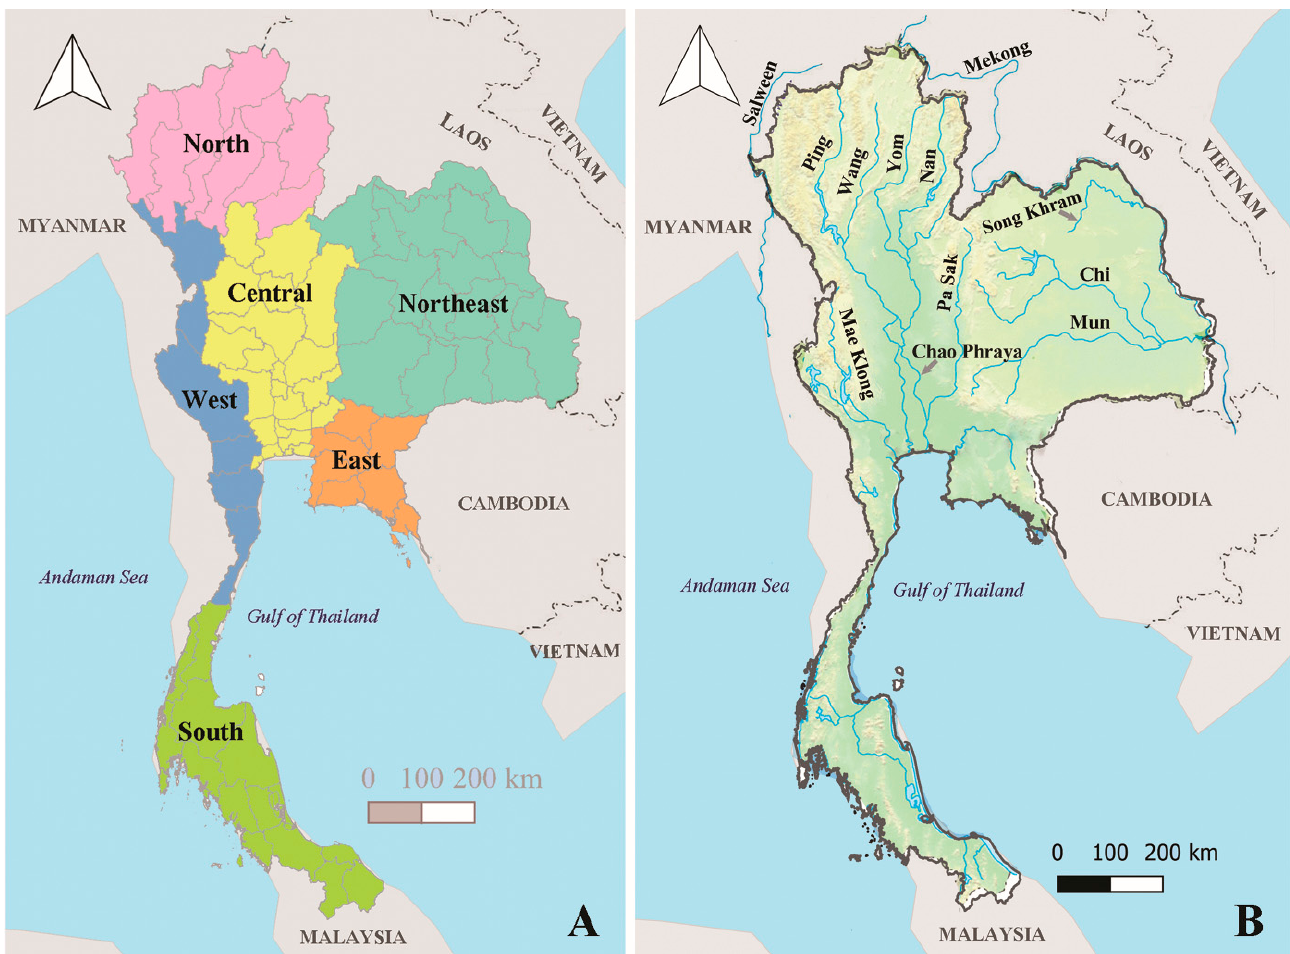
Figure 1. The map of Thailand displays six geographical regions ( A ) and major rivers ( B ). Table 1. Information on sampling projects of the surveyed waterbodies in Thailand. The regions in Thailand are given by; N = North, NE = Northeast, C = Central, E = East, W = West, and S = South.